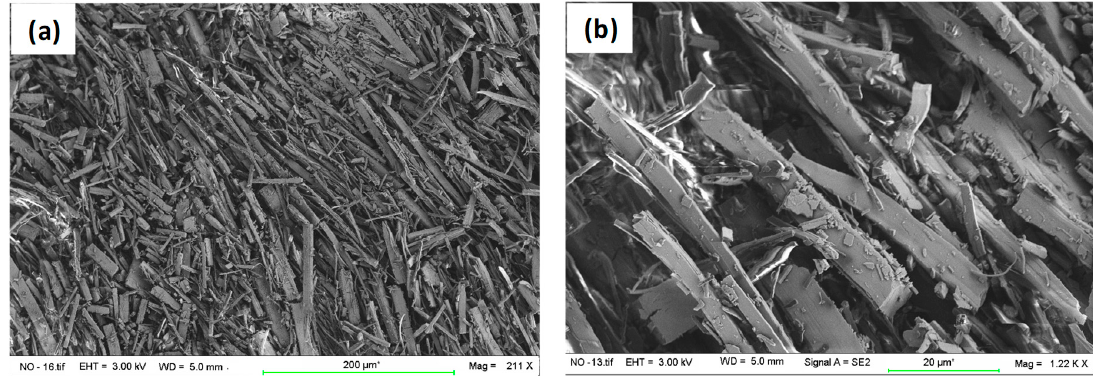
Figure 2. SEM images of diNO show the microcrystalline fibrous network: ( a ) overview; ( b ) magnified images.